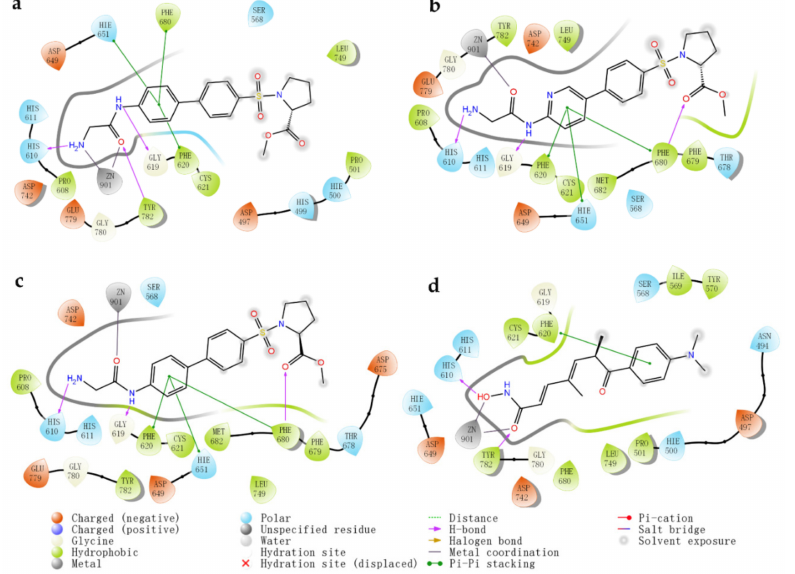
Figure 7. Two-dimensional diagram depicting HDAC6–ligand interaction of 7a ( a ), 7d ( b ), 13a ( c ), and TSN ( d ). Key amino acids and their binding interaction are